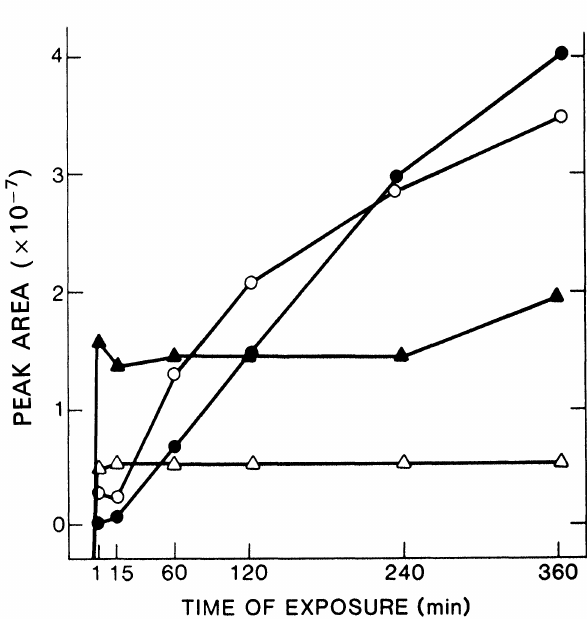
FIG. 2. A time course experiment on the formation of the major oxidation products (peak with retention time 31.95 min corresponding to SP8-1 has been marked with circles and a peak with retention time 28.01 min corresponding to SP_7 has been marked with triangles). Oxygen derived free radical flux was produced in the hypoxanthine/xanthine oxidase (85 mU) system in the presence of mM deferoxamine and 40 mM o-mannitol or 50 #M FeCI3 H20 and 50 #M EDTA to produce superoxide (open symbols) or hydroxyl radicals (closed symbols), respectively.